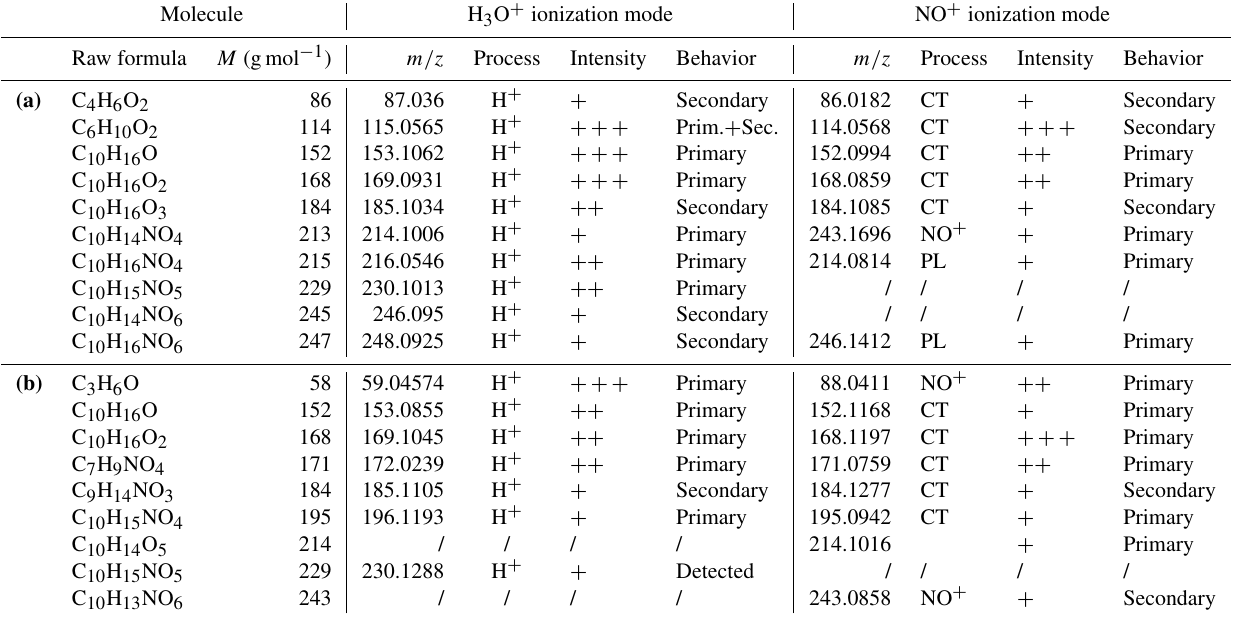
Table 4. Products detected for γ -terpinene (a) and α -terpinene (b) with PTR-ToF-MS H 3 O + and NO + ionization modes: formula and molar masses, detected masses, ionization processes (H + is proton adduct; NO + is NO + adduct; CT is charge transfer; and PL is proton loss), peak intensity, and